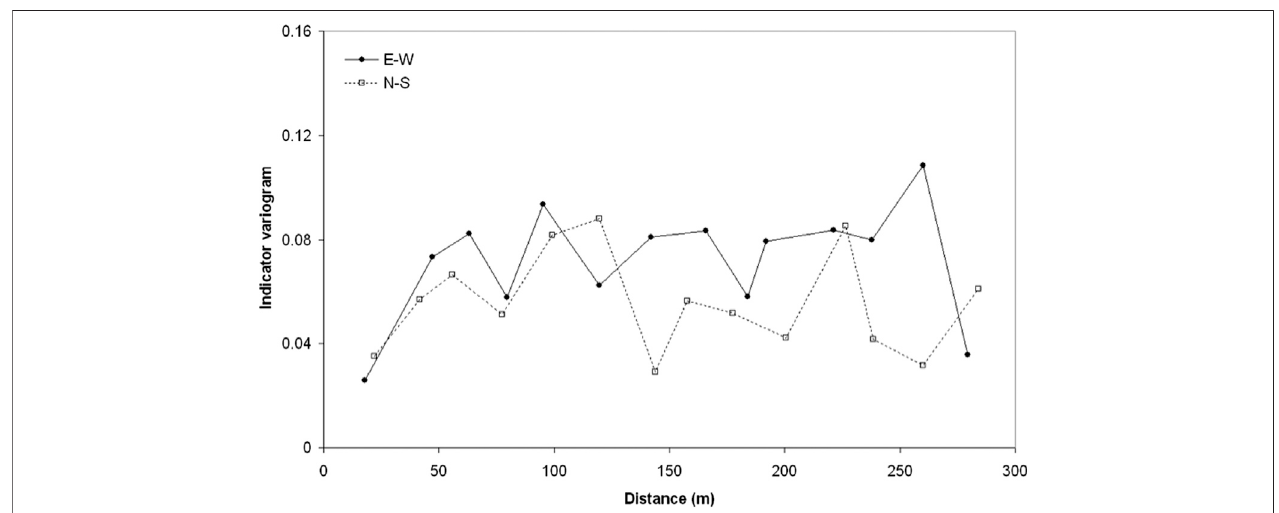
FIGURE 5 | Indicator variograms for hydrofacies F5 for the two perpendicular directions most likely to exhibit anisotropic behavior.